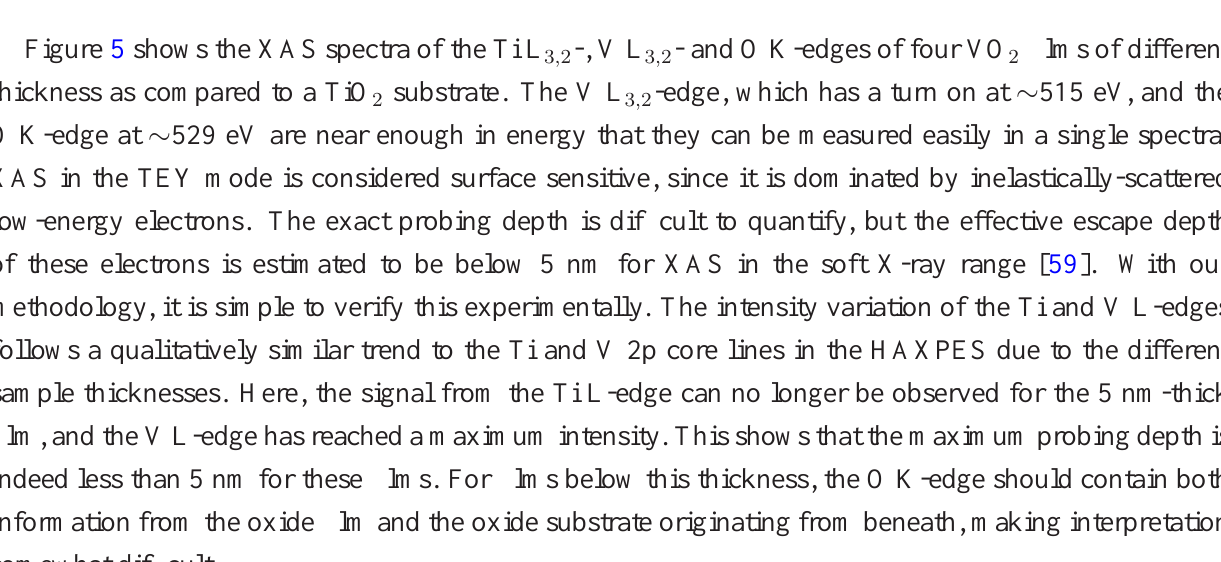
-, V L - and O K-edge XAS spectra of four VO 3 , 2 3 , 2 single crystal for 2